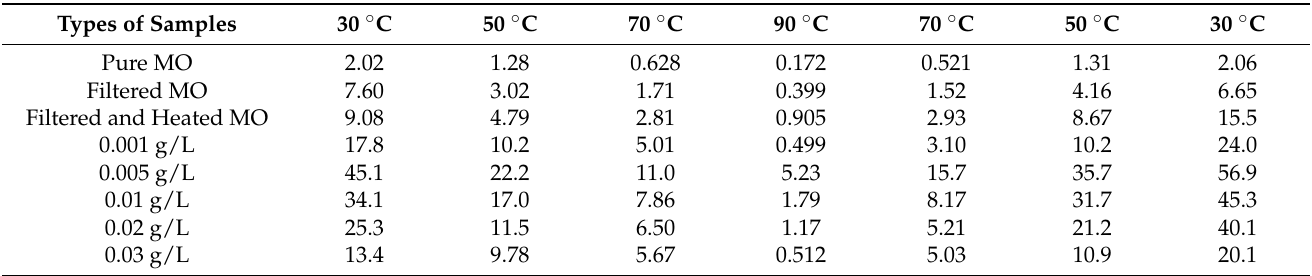
Table 6. Resistivity (ohm-cm × 10 14 ) value of different type of samples with temperature increasing from 30 ◦ C to 90 ◦ C and falling to 30 ◦ C.